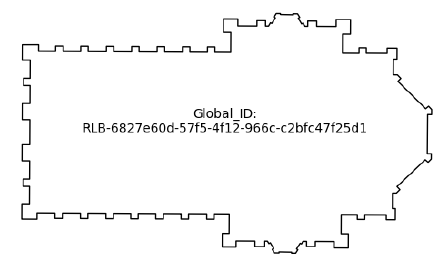
Figure 4. Example of Global ID of Milan’s Cathedral